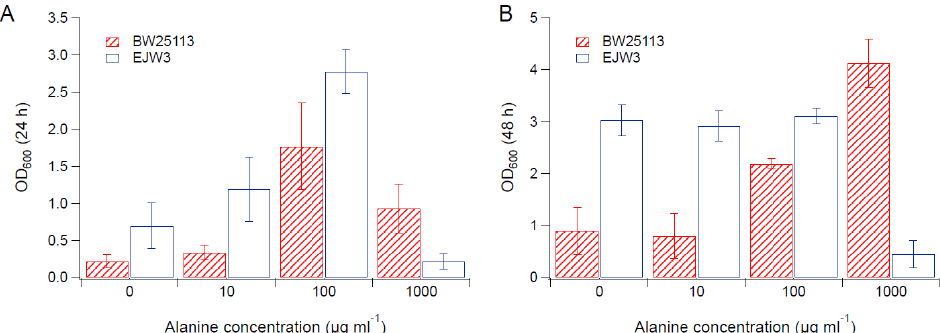
Figure 5. Cell density in M9 supplemented with 0.65 M NaCl and alanine. ( A ) Cell density after 24 h. ( B ) Cell density after 48 h. Error bars are standard deviations.